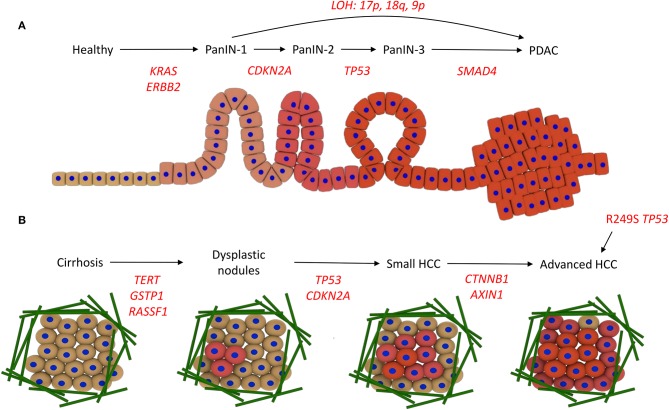
Driver mutations in PDAC and HCC development. (A) Development of PDAC. The acquisition of KRAS and ERBB2 activating mutations drives progression to PanIN-1, CDKN2A promoter methylation and inactivity leads to PanIN-2, TP53 inactivity promotes progression to PanIN-3, and then mutations in SMAD4 lead to PDAC. Alternatively, loss of heterozygosity (LOH) promotes PanIN-1 to progress directly to PDAC. (B) Development of HCC. Various risk factors promote cirrhosis, involving the deposition of a large amount of ECM fibers (green). Mutations in the promoters for TERT, GSTP1, and RASSF1A drive the acquisition of dysplastic nodules, then mutations in TP53 and the CDKN2A promoter promote small HCC development. Wnt signaling mutations, i.e., in CTNNB1 and AXIN1, lead to advanced HCC. Alternatively, aflatoxin exposure can promote direct progression to HCC via the R249S mutation in TP53.